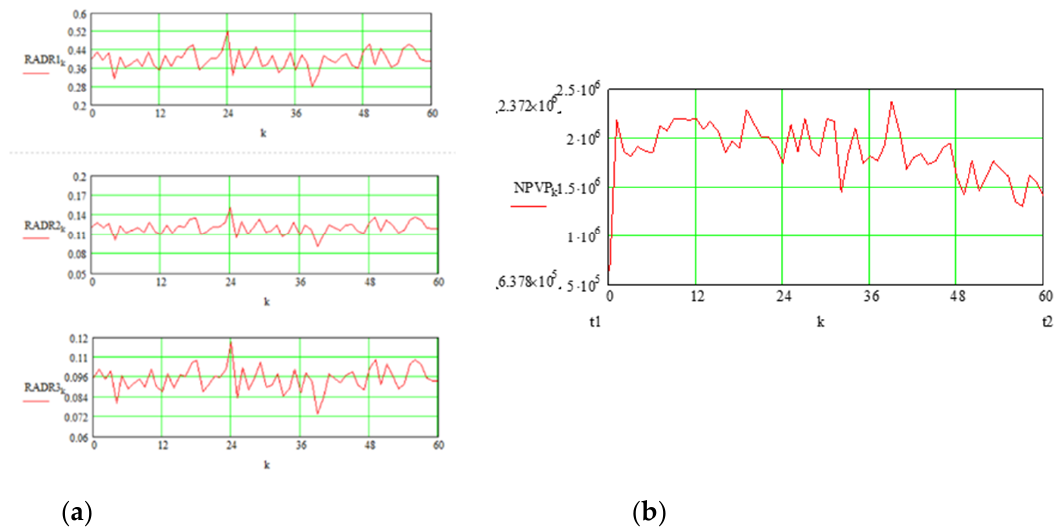
Figure 8. Graphical representation of the RADRs ( a ), and total NPV ( b ) dynamics for Scenario B6 (m = 2, σ = 0.20; term structure of the interest rate not considered; interest rate seasonal rate fluctuations not considered).